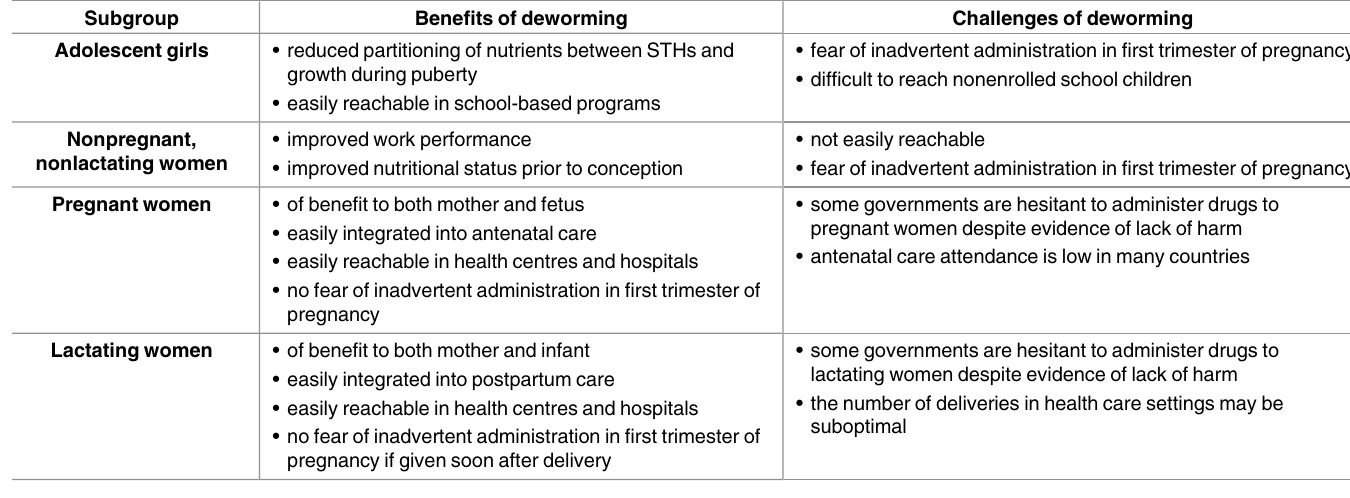
Table 1. Summaryof benefits and challenges of including subgroups of WRA in deworming